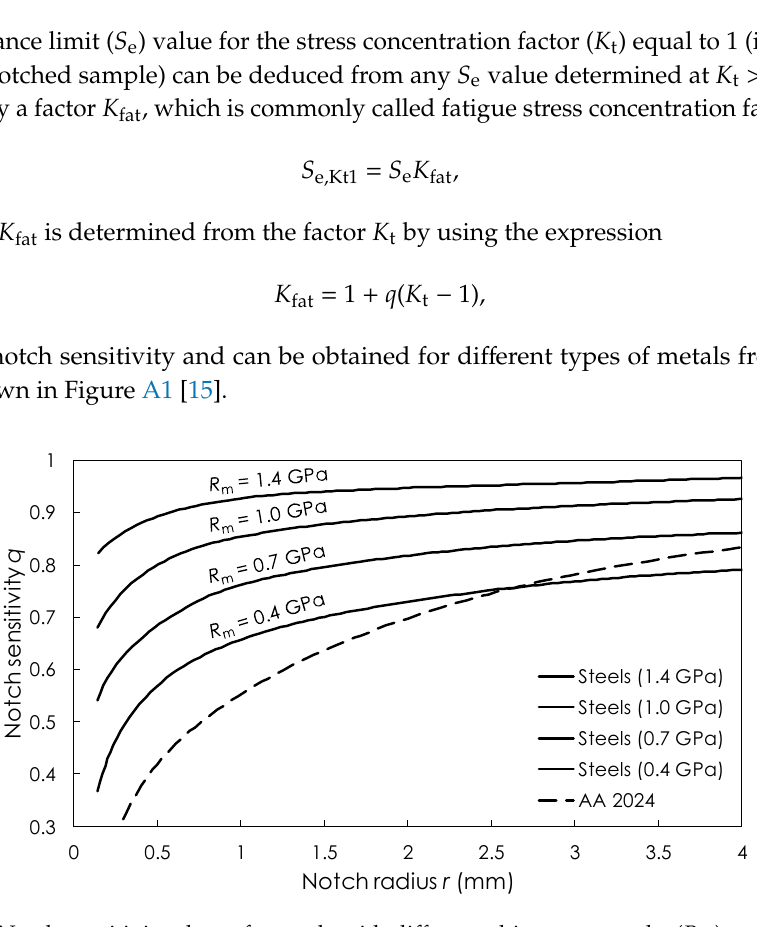
Figure A1. Notch sensitivity charts for steels with different ultimate strengths ( R m ) and aluminum alloys AA 2024 subjected to reversed bending or reversed axial loads. For larger notch radii, the use of the values of q corresponding to r = 4 mm is recommended [15].